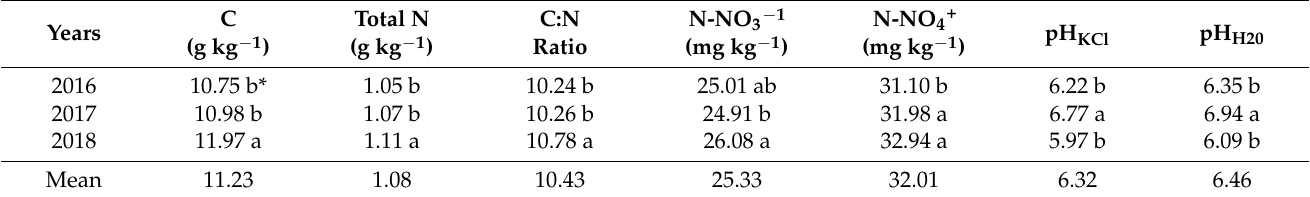
Table 3. Physical and chemical properties of soil under JA